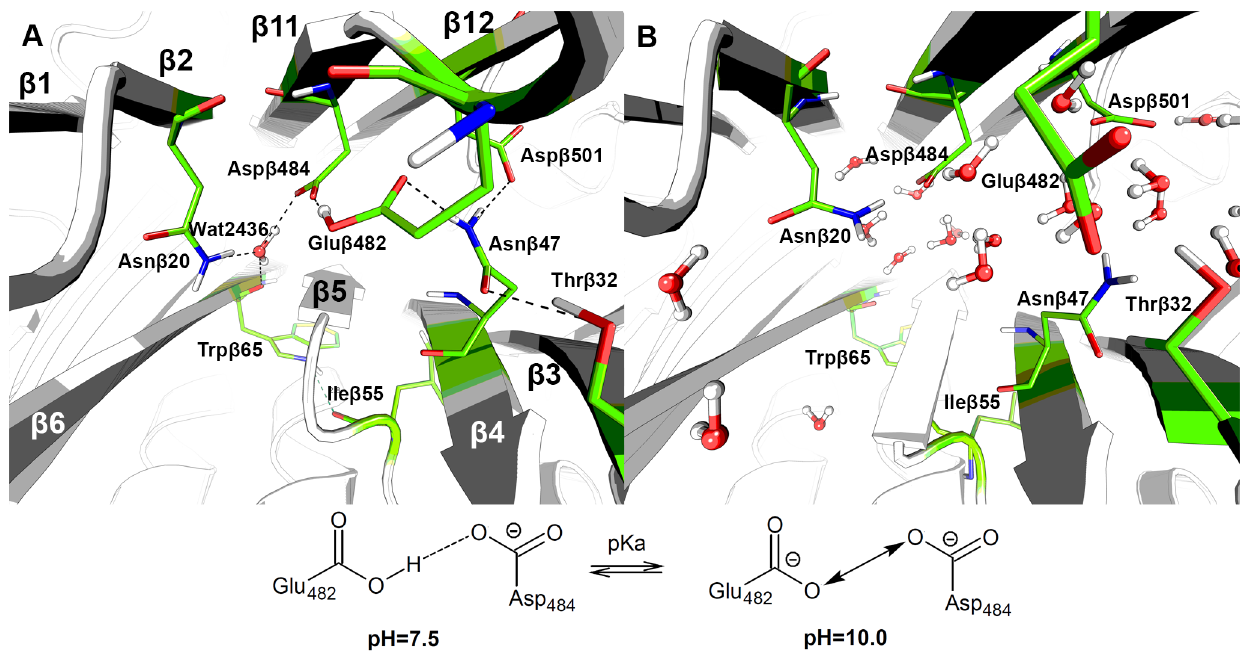
Figure 2. The network of hydrogen bonding interactions between the two b -layers of the abba -core B1 domain of Ec PA is present at pH 7.5 (A) and collapses at pH 10.0